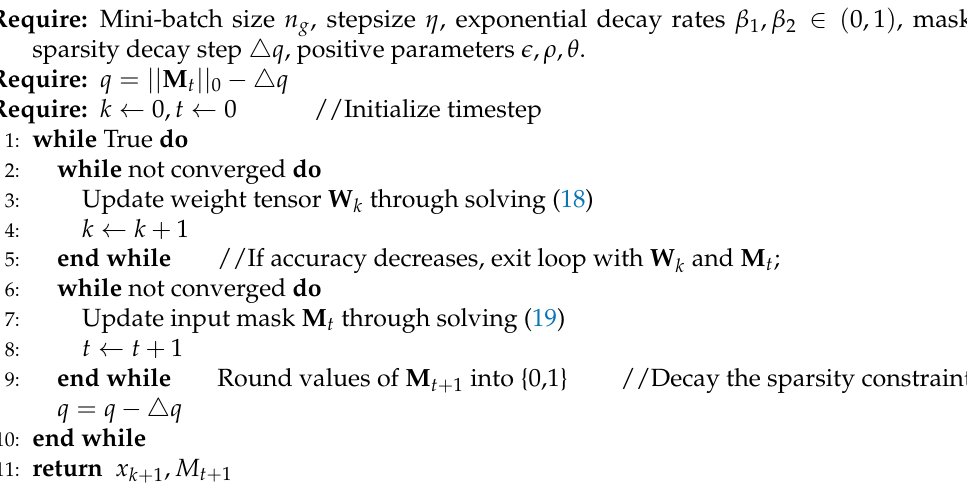
Algorithm 2 Energy-Constrained Depth Estimation DNN